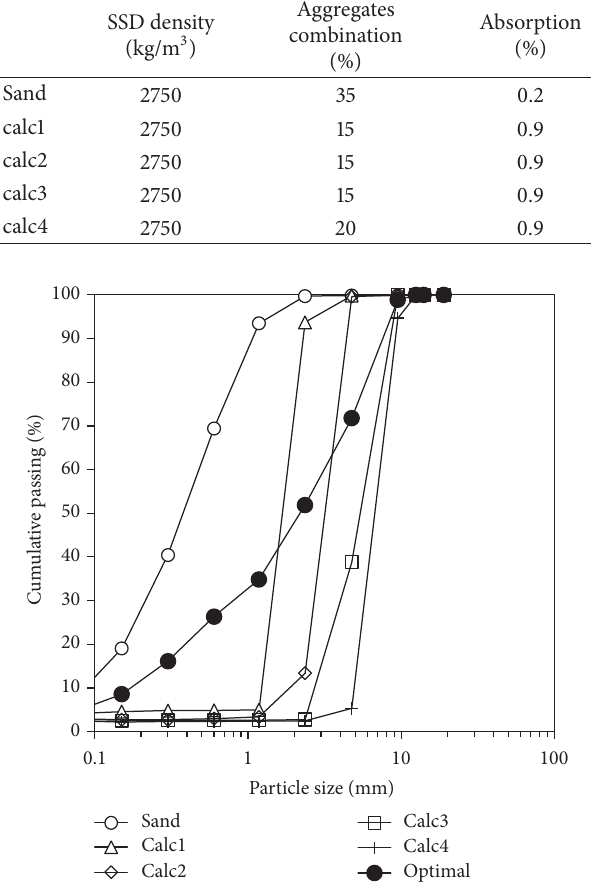
Figure 1: Aggregate size distribution of five different classes: sand, calc1–calc4, and optimal (Fuller’s)